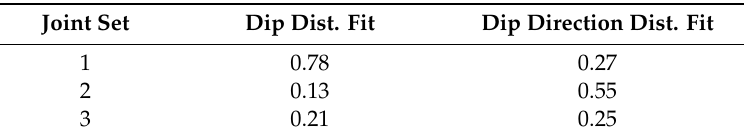
Table 2. Pearson’s χ 2 probability values for the goodness of fit tests for measured orientation PDF adopted. Values over 0.05 are considered an adequate fit.